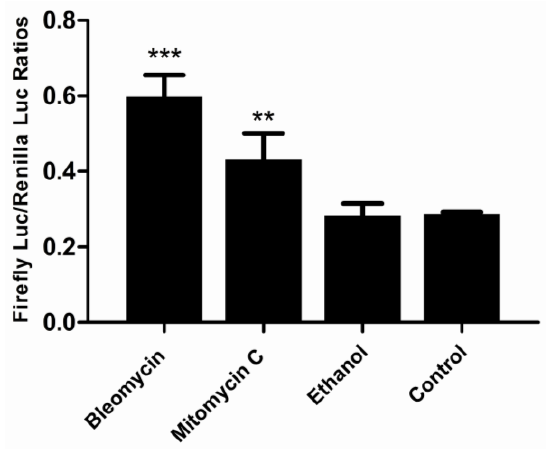
Figure 6. Comparison of the DNA damage-induced responses of the stable p21FGLuc cells to bleomycin, mitomycin C and ethanol. The p21FGLuc cells were exposed to 30 μg/mL bleomycin for 4 h, 10 μg /mL mitomycin C for 2 h and 30% (v/v) ethanol for 1 h, respectively. ** Shows the highly significant difference (p < 0.01). *** Shows the very highly significant difference (p < 0.001). Data are expressed as mean ±